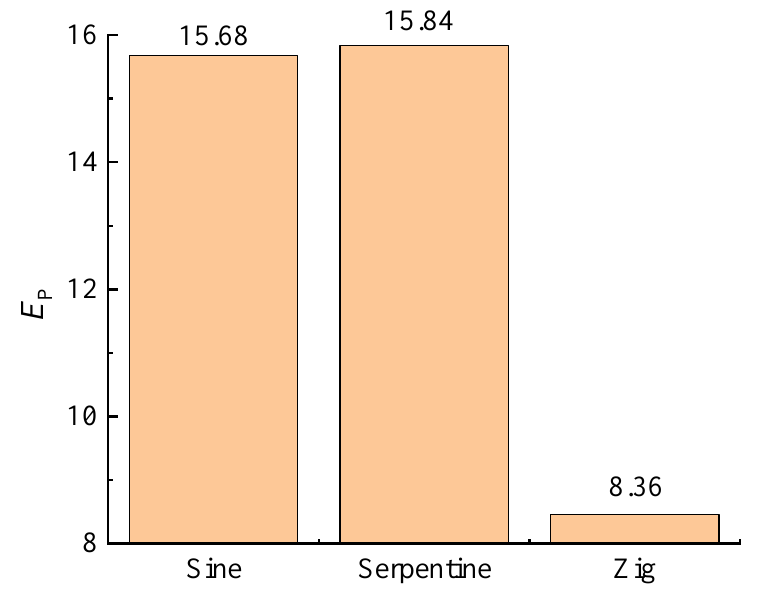
Figure 26. Comparison of different channels ( Re = 2500, A = tan57.5° , and q = 1 kW/m 2 ). The 𝐸 P of Sine channel is 15.68, while the 𝐸 P of Serpentine channel is 15.84. In con-